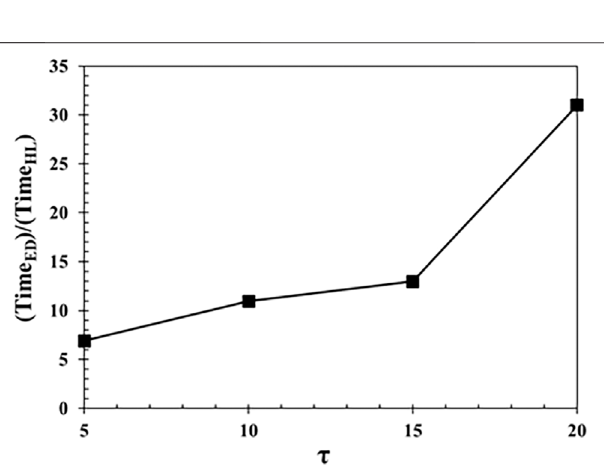
FIGURE 9 | Comparison of Time ED Time mechanical models.